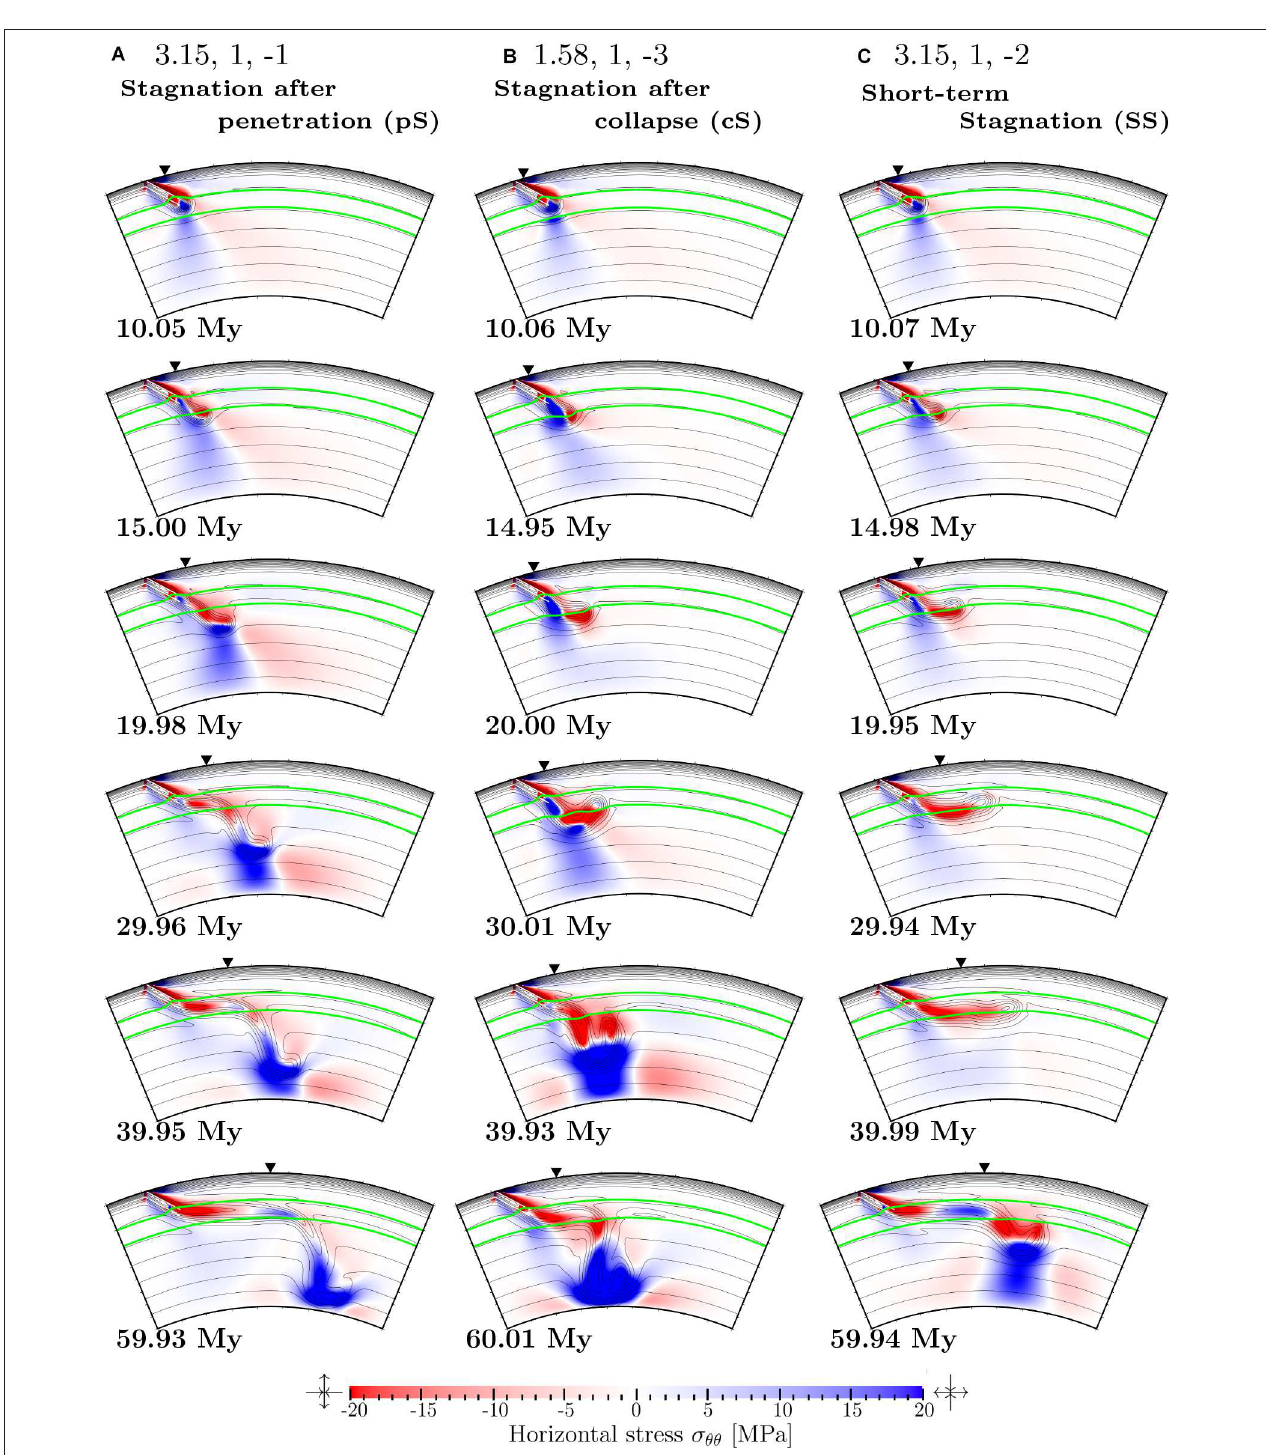
FIGURE 5 | Snapshots of the distributions of temperature T (contours) and horizontal stress σ θθ (colors) for the time instances indicated in the figure, obtained for the cases with (A) stagnation after penetration, (B) stagnation after collapse, and (C) short-term stagnation. Indicated at the top of respective frames are the trench retreat velocity v tr [cm/yr], the viscosity jump between the upper and lower mantle r η , and the Clapeyron slope at the 660 km discontinuity γ 660 [MPa/K] for each case, respectively. The contour interval for T is 100 ◦ C. The colorscale for σ θθ is indicated at the bottom of figure. The regions with σ θθ < 0 is under horizontal compression (vertical extension), while those with σ θθ > 0 is under horizontal extension (vertical compression). We also show by the green lines in each figure the phase boundaries at around 410 km and 660 km depths.